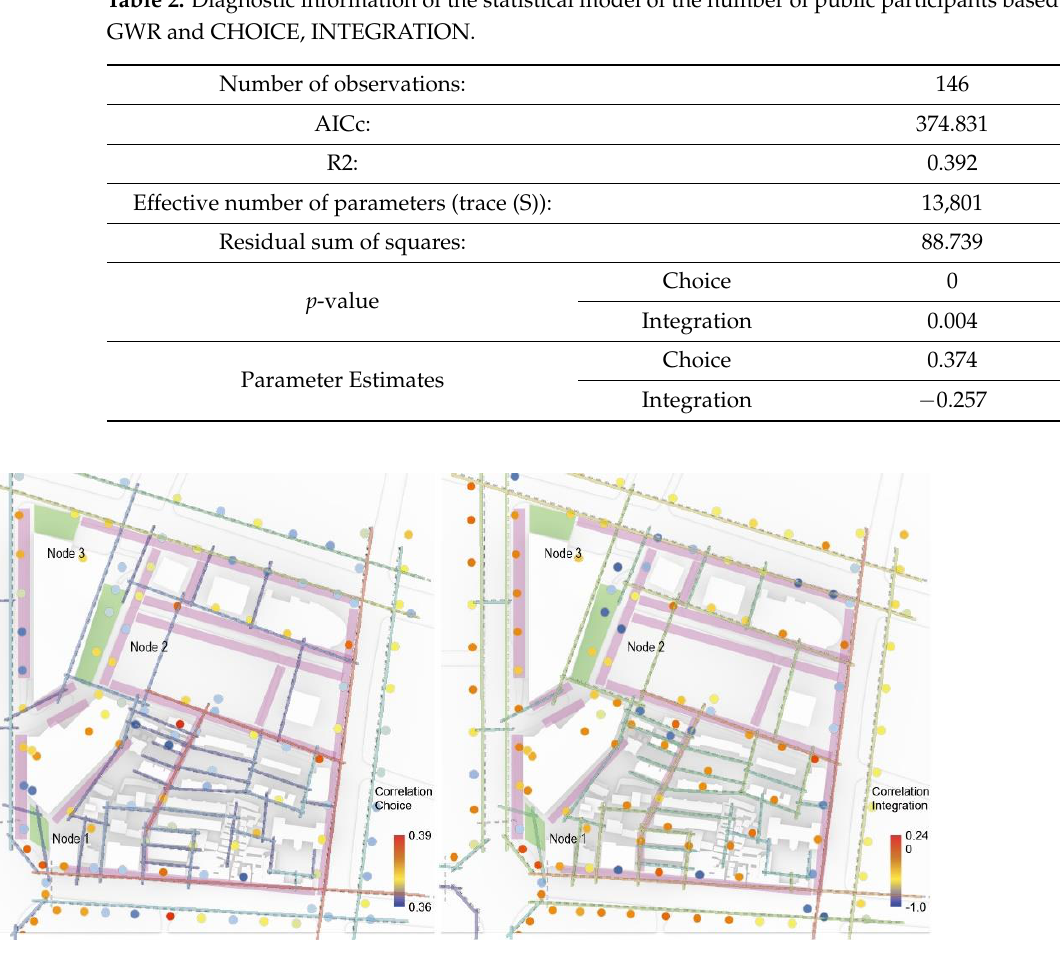
Figure 7. Distribution of the correlation between public participation, and choice and integration.